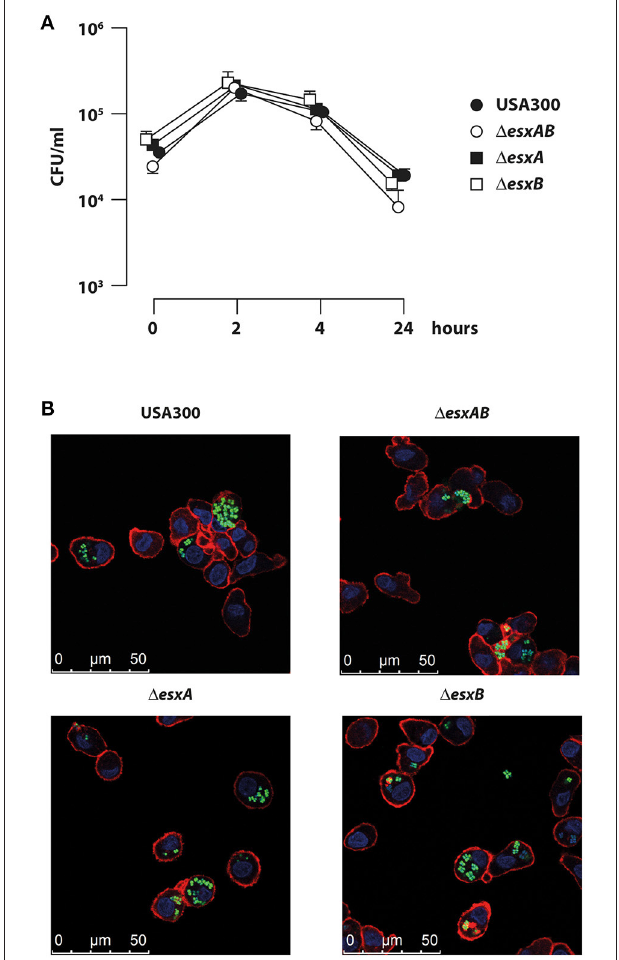
FIGURE 1 | Infection of human DC with wild type USA300 and esx mutants. DC were infected with wild type USA300 or 1 esxAB , 1 esxA, and 1 esxB mutant strains for the indicated time points. (A) Cells were extensively washed to eliminate extracellular bacteria and then lysed for intracellular bacteria quantification by CFU counting. The values are the mean ± SEM of 3 independent experiments. (B) DC were infected with wild type USA300 or esx mutants expressing GFP. Four hours after infection cells were analyzed for bacteria internalization by confocal microscopy following DC cell surface and nucleus visualization using phalloidin-TRITC probe and DAPI, respectively. Scale bar 0–50 µ